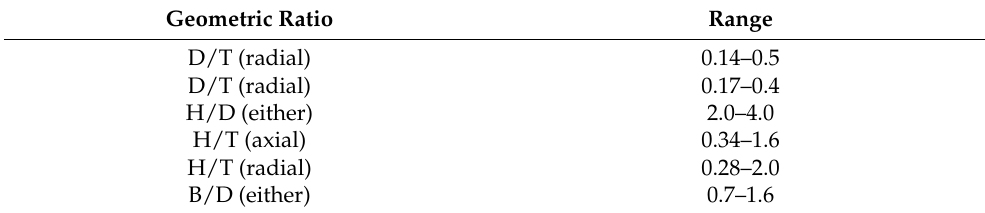
Table 2. Tank and impeller geometries for mixing [20].